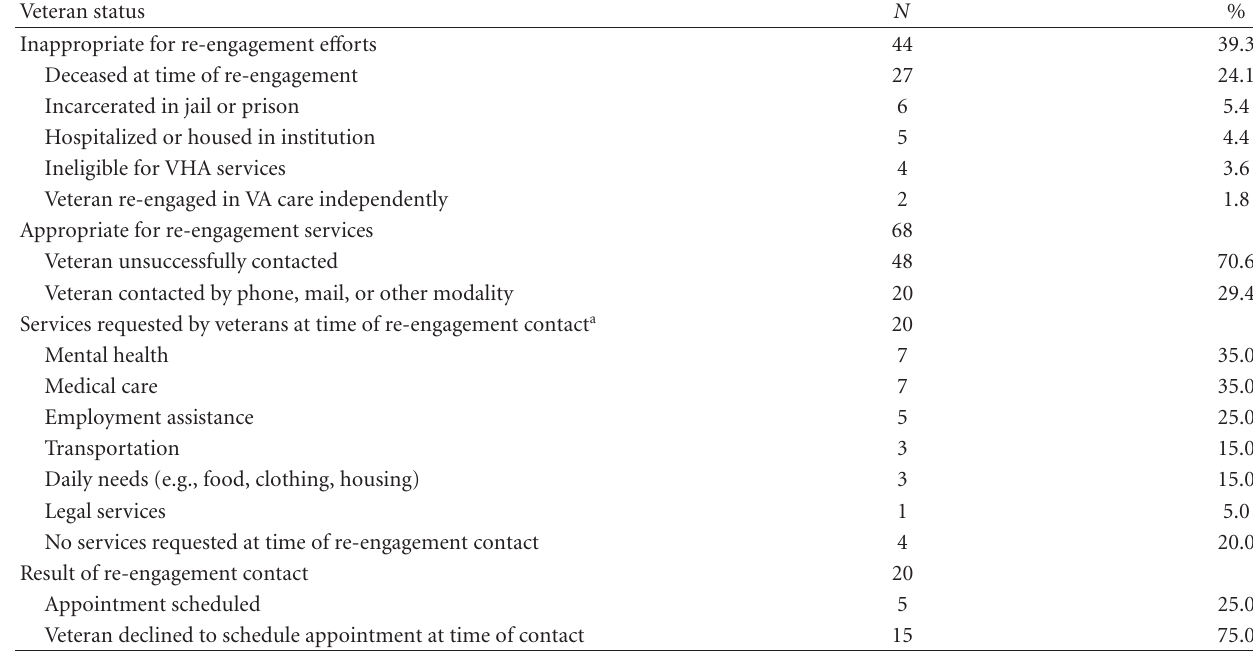
Table 3: Veteran status determined through re-engagement contacts ( N =